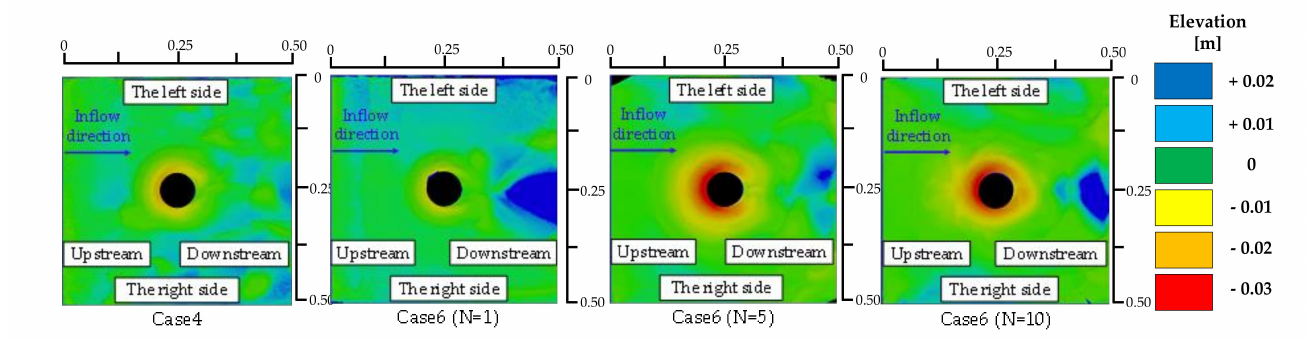
Figure 2. Local scour depth after the experiment for Cases 4 and 6. ( H 1 = 0.075 m, T = 1800